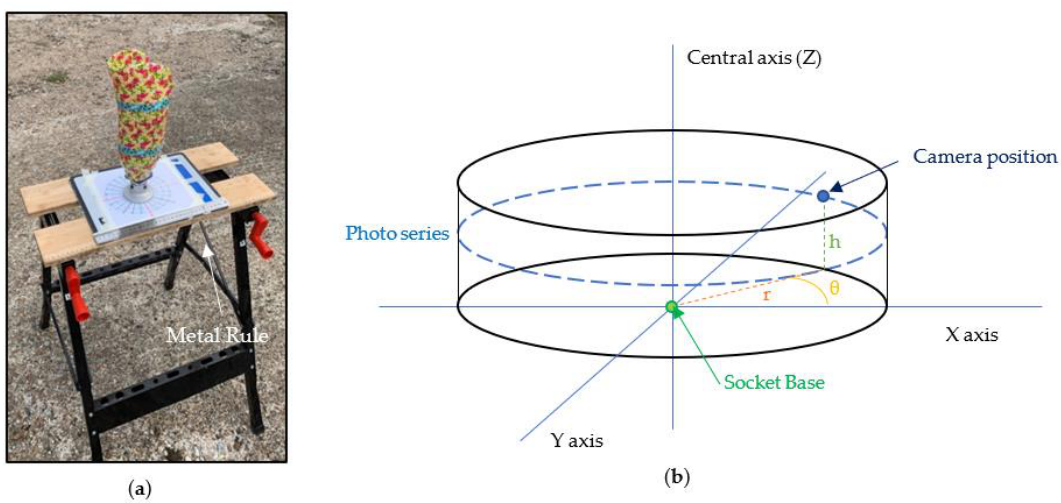
Figure 2. Illustration of experiment set up; ( a ) taped socket positioned on platform with ruler; ( b ) cylindrical co-ordinate system used for camera positioning.